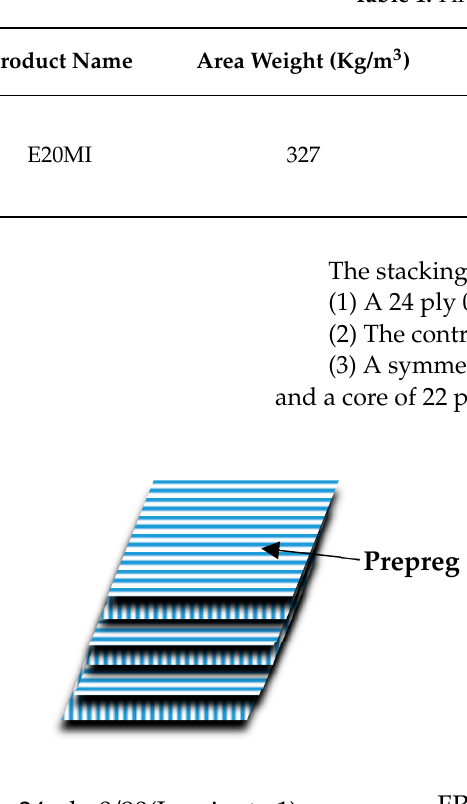
Table 1. Fire retardant mat (E20MI) specifications.